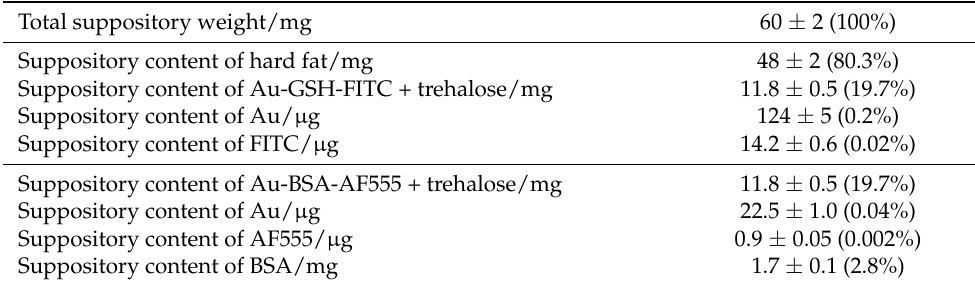
Table 1. Characterization of gelatin capsules, loaded with either Au-GSH nanoparticles or Au-BSA nanoclusters. Given are weight percentages with respect to the total weights of nanocarriers, including trehalose (±indicates the standard deviation).